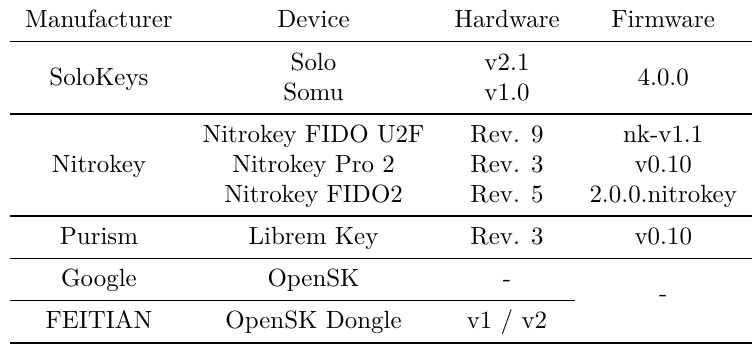
Table 1: Analyzed security tokens including their hardware and firmware